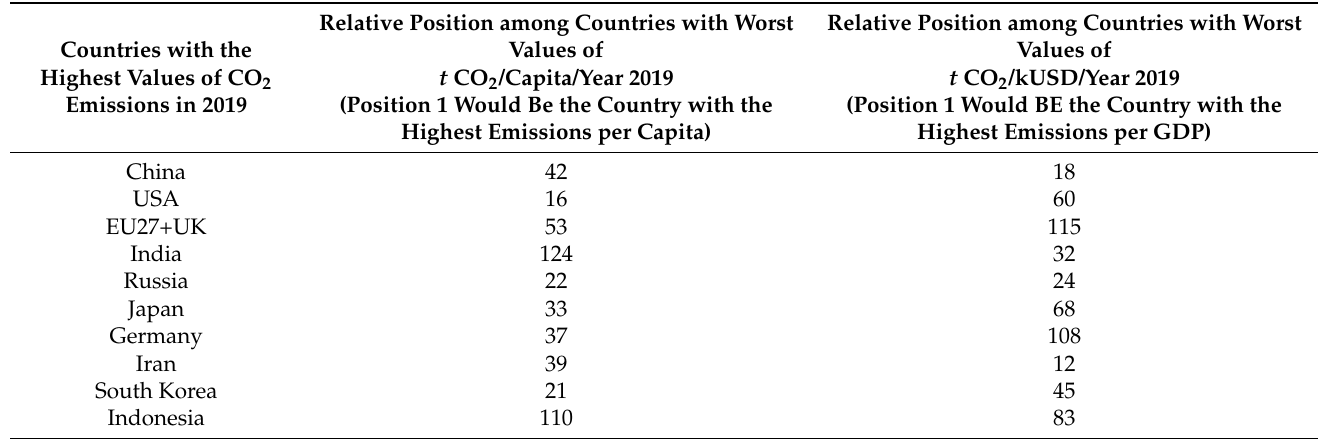
Table 7. Position of the countries with the highest values of emissions in the emissions per capita and per kUSD in 2019. Own elaboration.